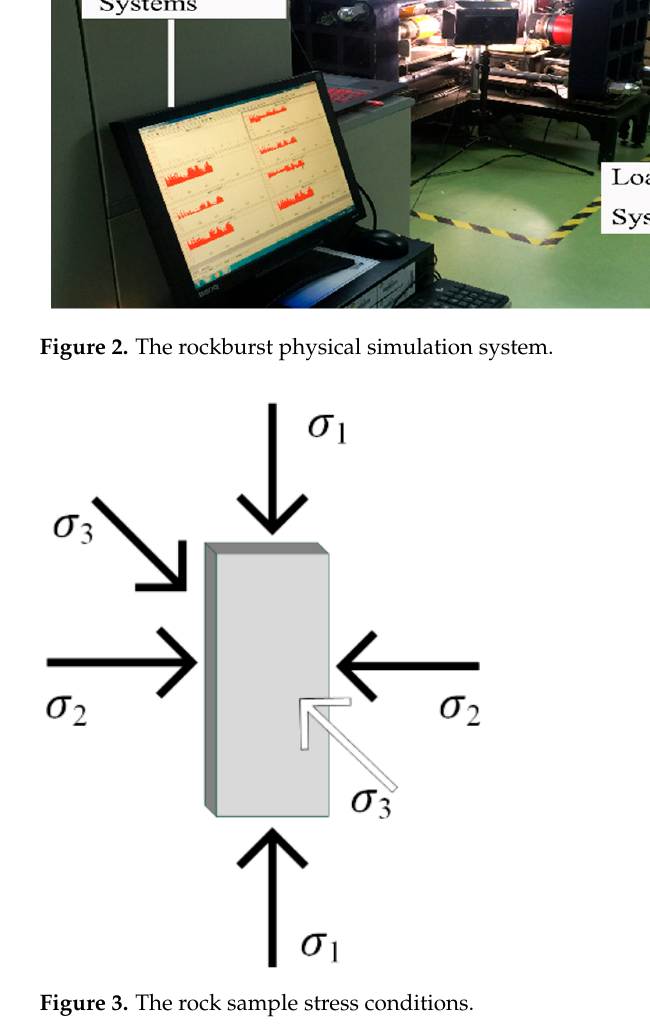
Figure 3. The rock sample stress conditions.